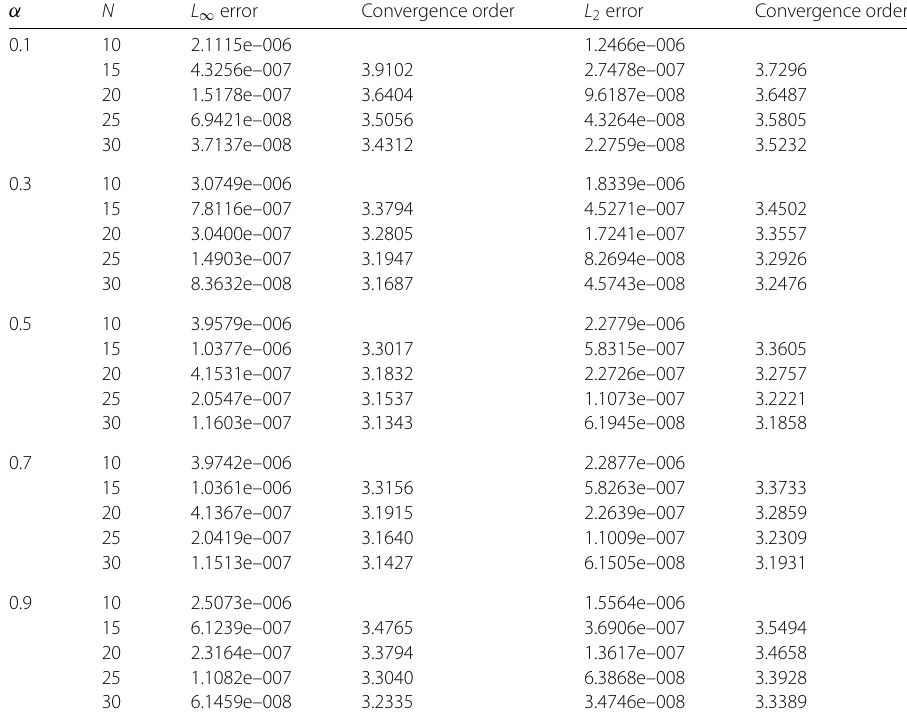
Table 3 The L ∞ , L 2 errors and temporal convergence orders for Example 2